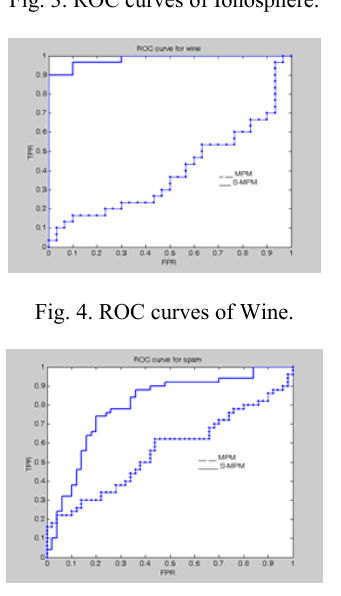
Fig. 3. ROC curves of Ionosphere.